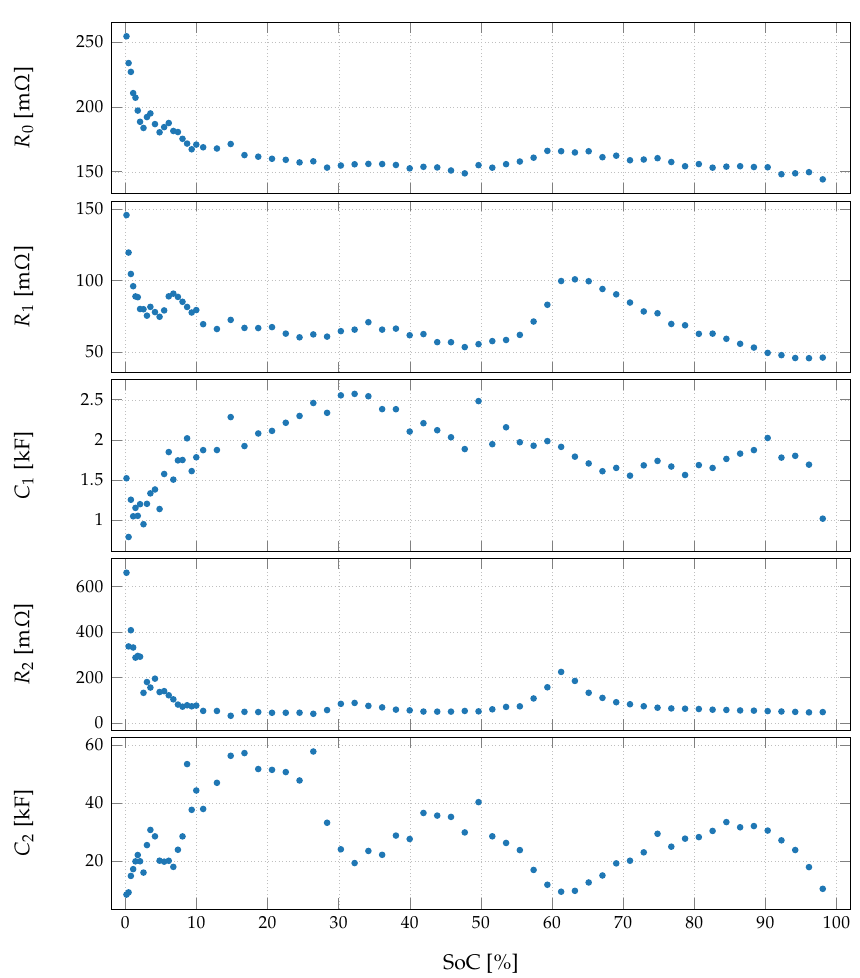
Figure 12. Identified parameters for the 2 RC model according to the related SoC.